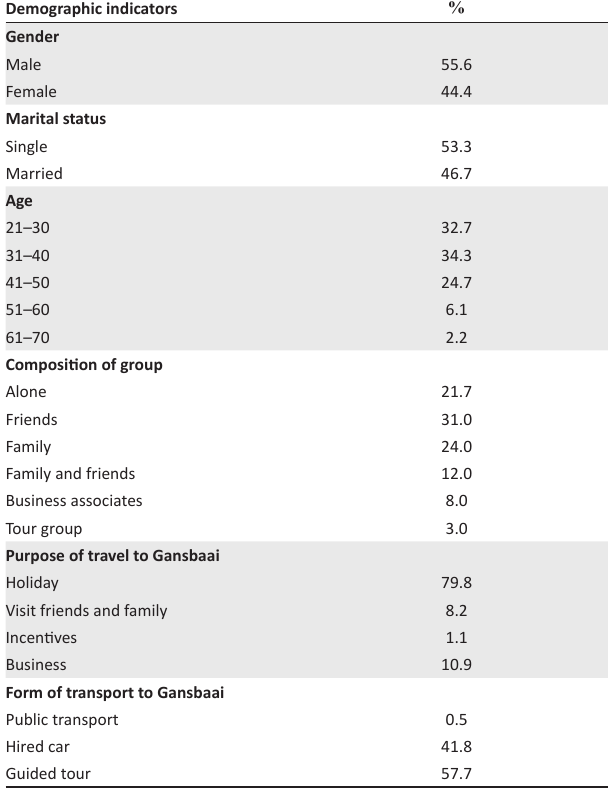
TABLE 2: Demographic profile.